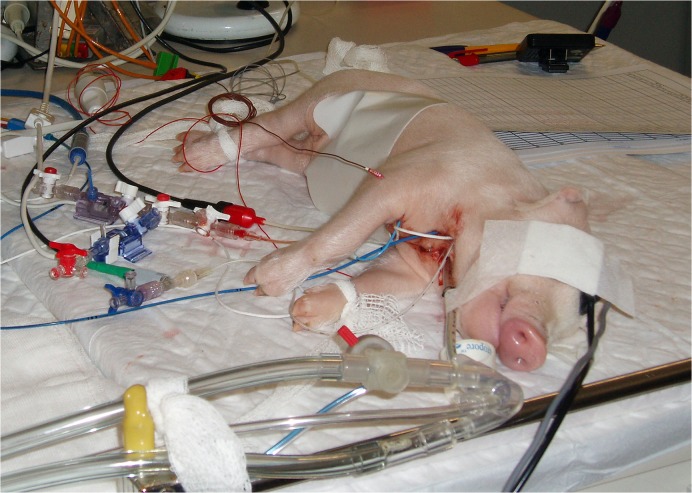
Piglet.Panoramic view of the experimental model in newborn piglet.